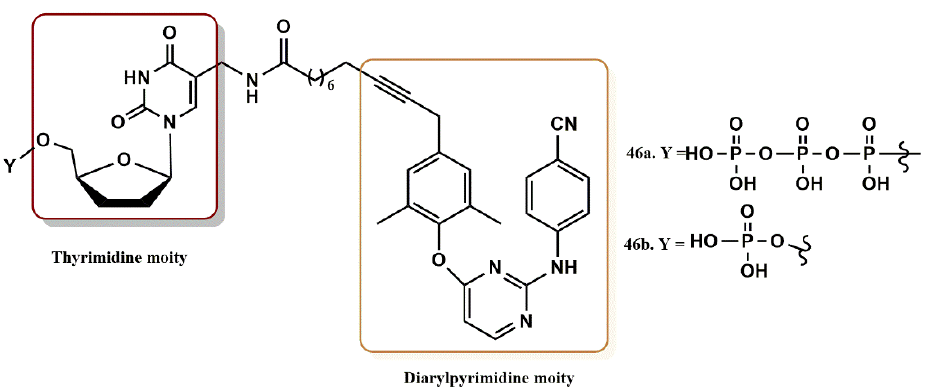
Figure 32. Dual RT pharmacophores of new active synthesized compounds 46a-b .